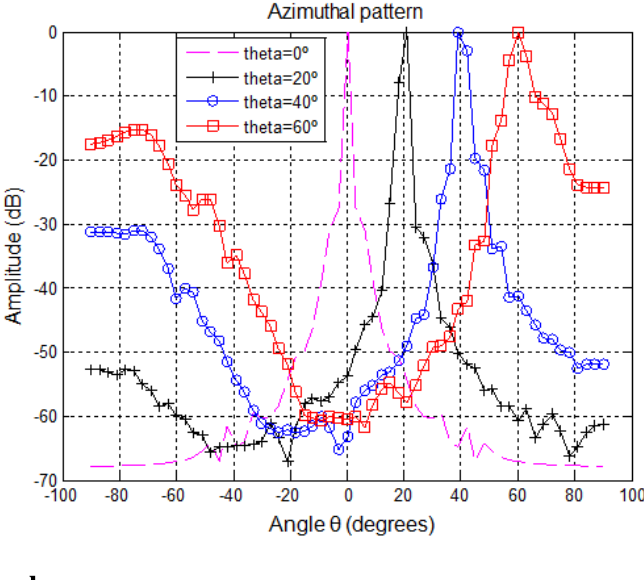
Figure 4. Array azimuth pattern as the steered angle increases θ for N = 32 elements.